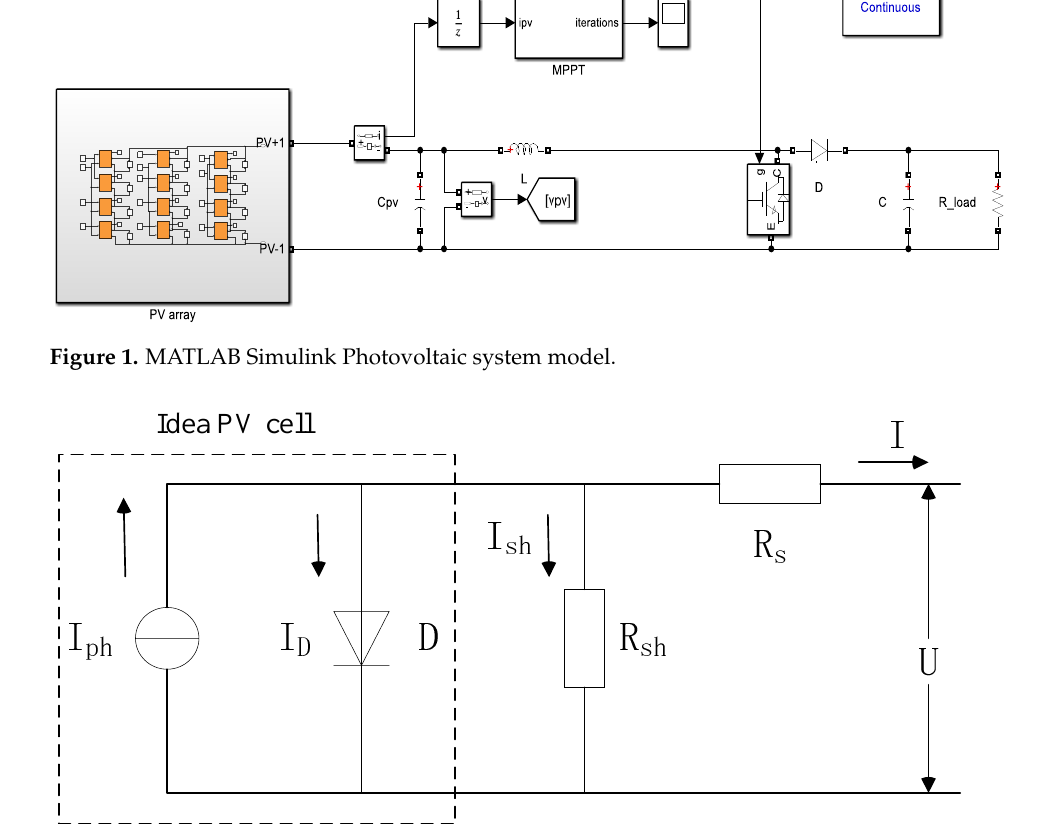
Figure 2. Equivalent circuit of a photovoltaic cell.